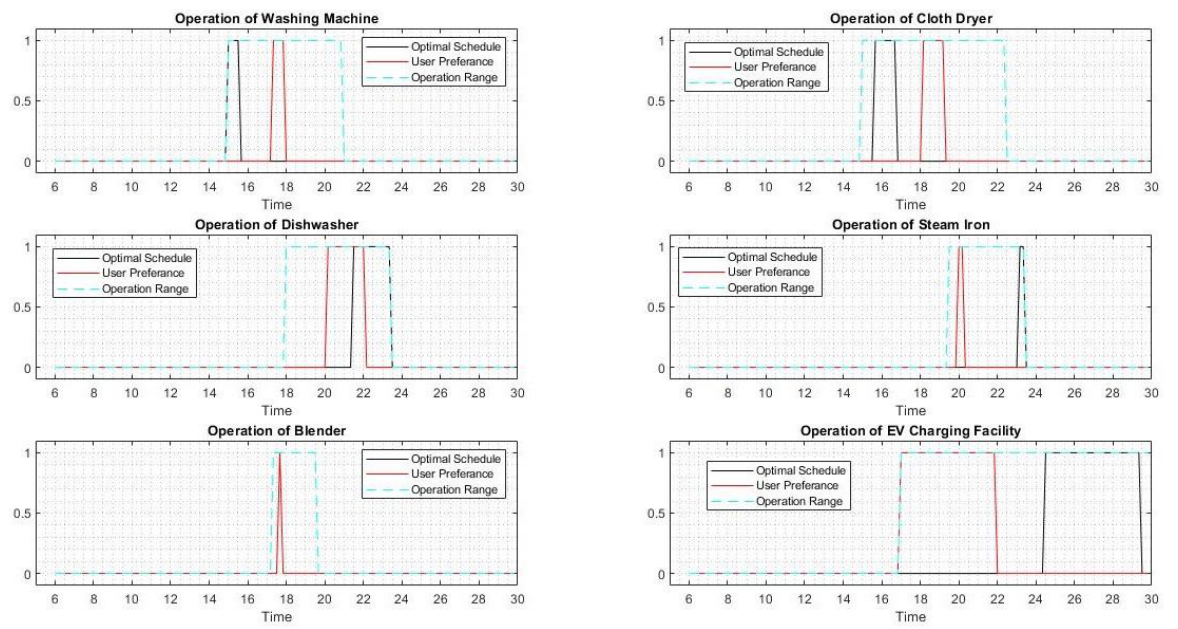
Figure 6. The operation of some assets in one of the residential buildings in the case they collaborate.